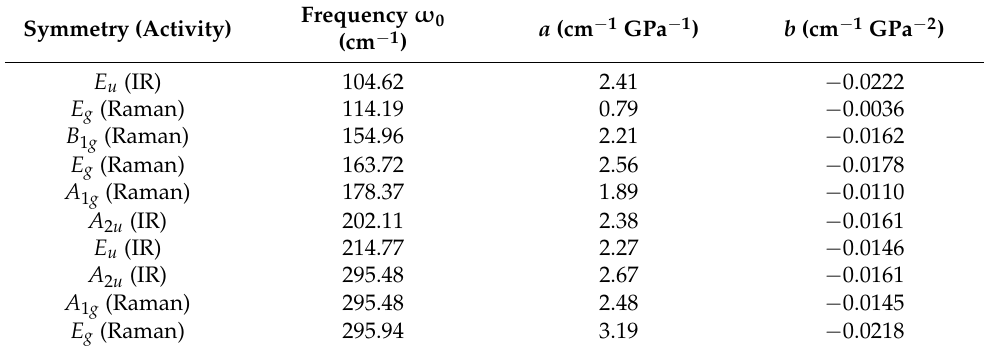
Table 3. Theoretical zero-pressure frequencies ( ω 0 ) for the zone-center phonons of RhNiAs and their corresponding linear and quadratic pressure coefficients, a and b , as obtained by fitting the PBE-vdW DFPT calculations of Figure 3 as a function of pressure ( P ) to the equation ω ( P ) = ω 0 + aP + bP 2 . Symmetry